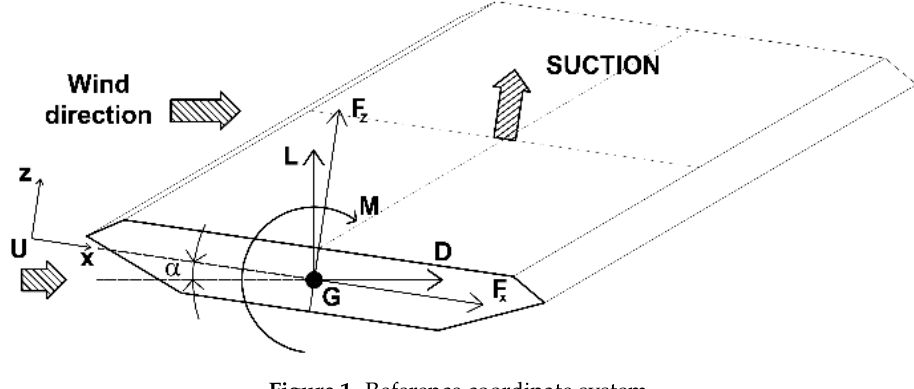
Figure 1. Reference coordinate system.